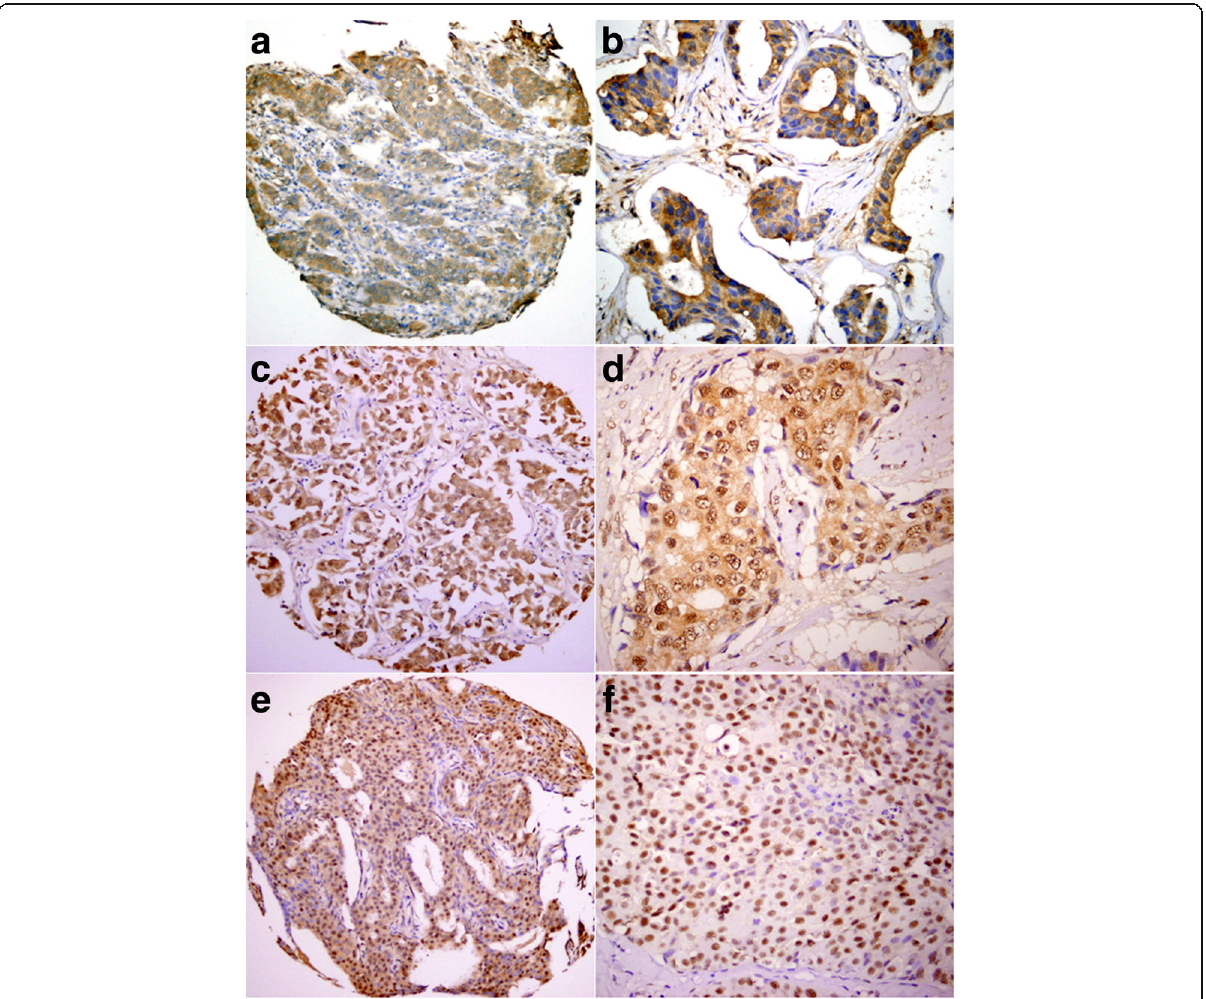
Fig. 3 FOXP1 expression patterns in IDC. The FOXP1 protein expression patterns in IDC tumor cells ranged from exclusive cytoplasmic ( a , TMA; b ×400) to mixed nuclear/cytoplasmic ( c , TMA; d ×400) and to exclusive nuclear ( e , TMA; f ×400)